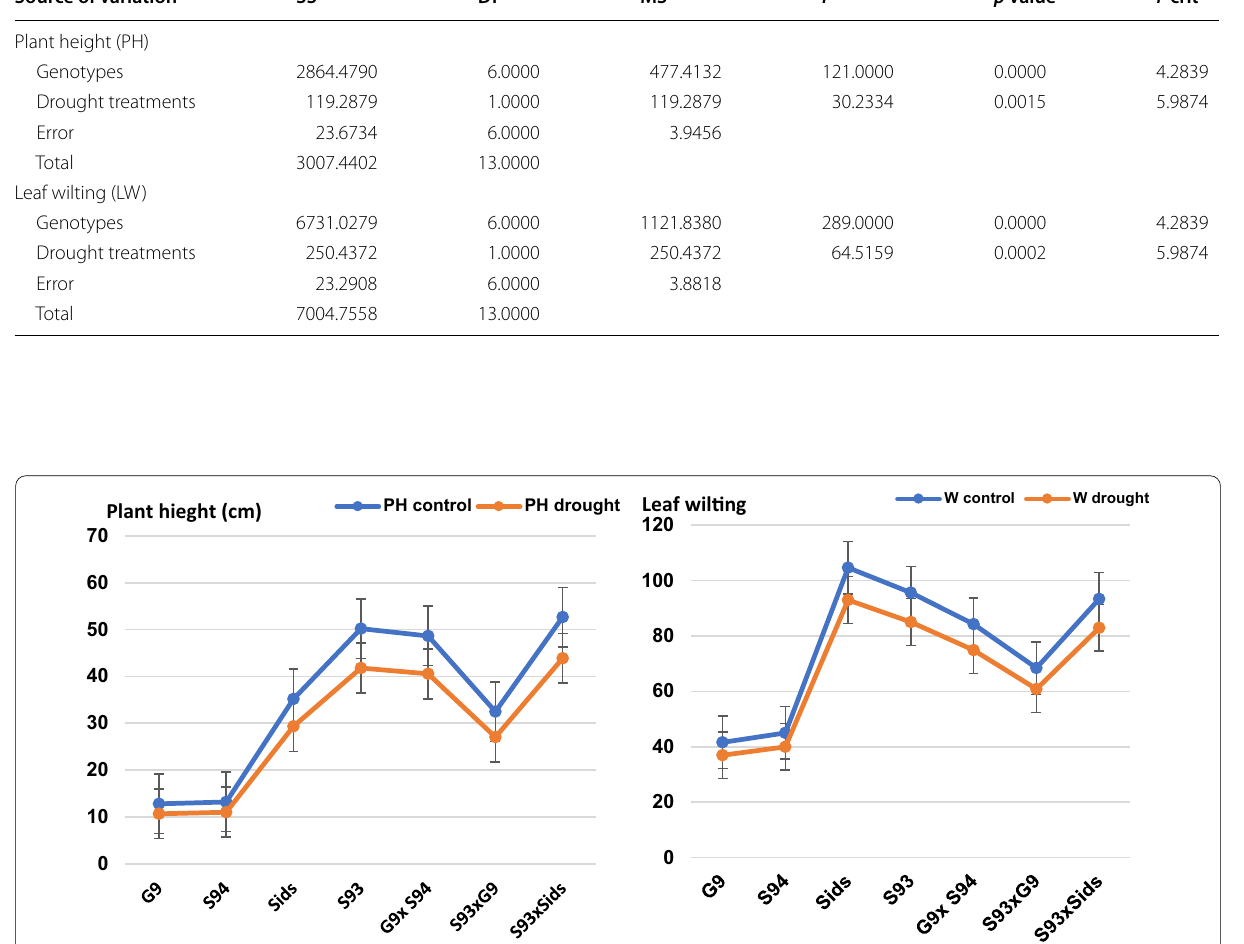
Fig. 1 Response of different parental genotypes to drought stress, i.e., the effect of drought on plant height (cm) and leaf wilting (days) of Wheat